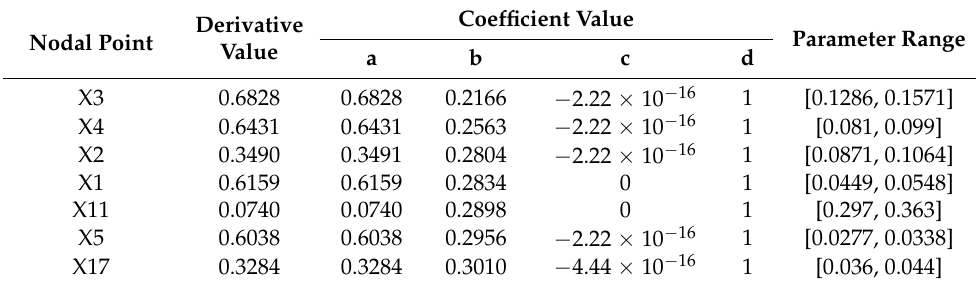
Figure 12. The tornado diagram dialog. Table 3. Partial root node derivatives and coefficient values.